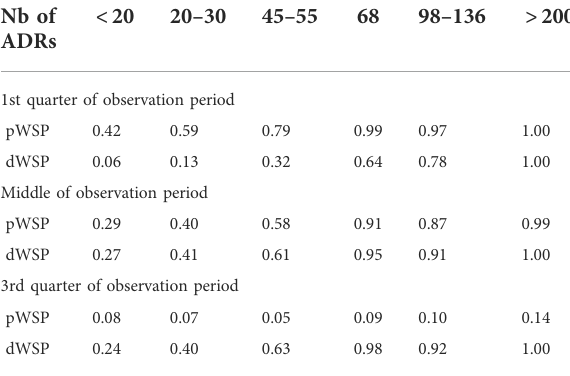
TABLE 3 Mean true positive rates per simulated number of ADRs and time of occurence. Nb of ADRs